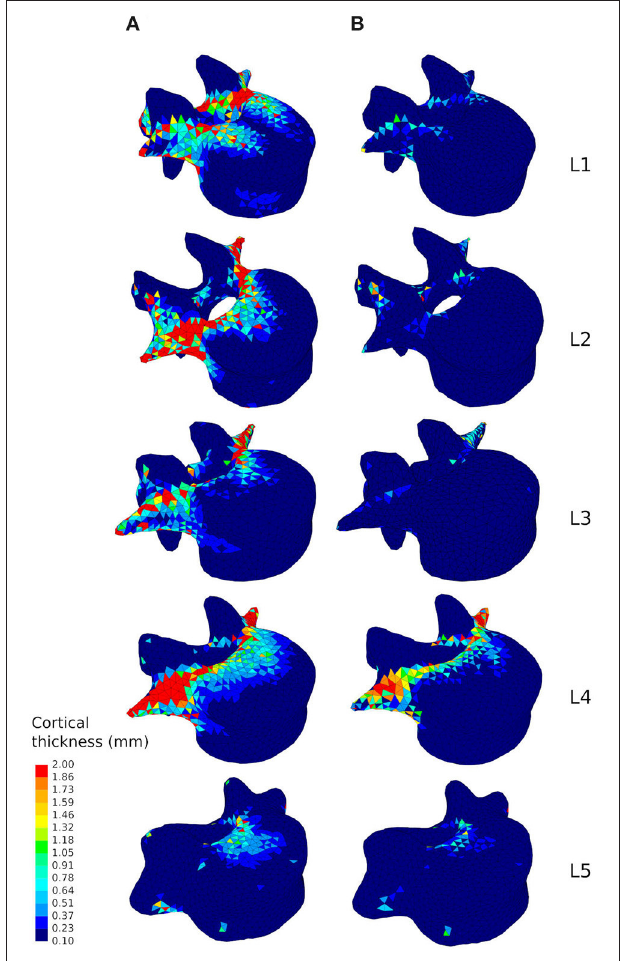
FIGURE 6 | Cortical thickness of the converged mesoscale structural models of the lumbar vertebrae ranging from 0.1 to 2.0 mm adapted to the healthy scenario (A) and the sedentary scenario (B) .